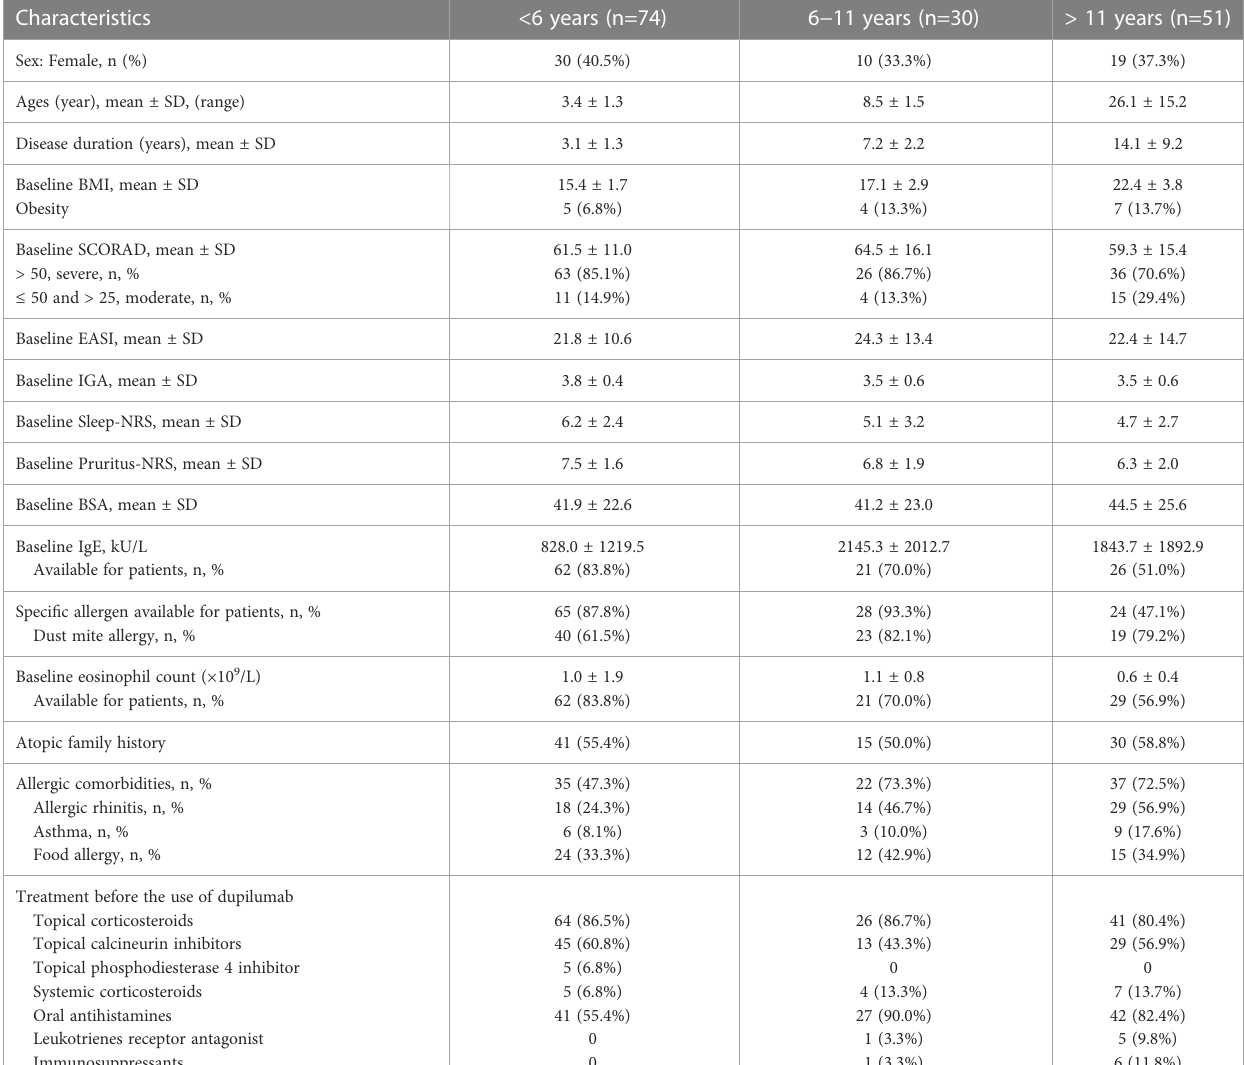
TABLE 1 Demographic data and clinical characteristics of study